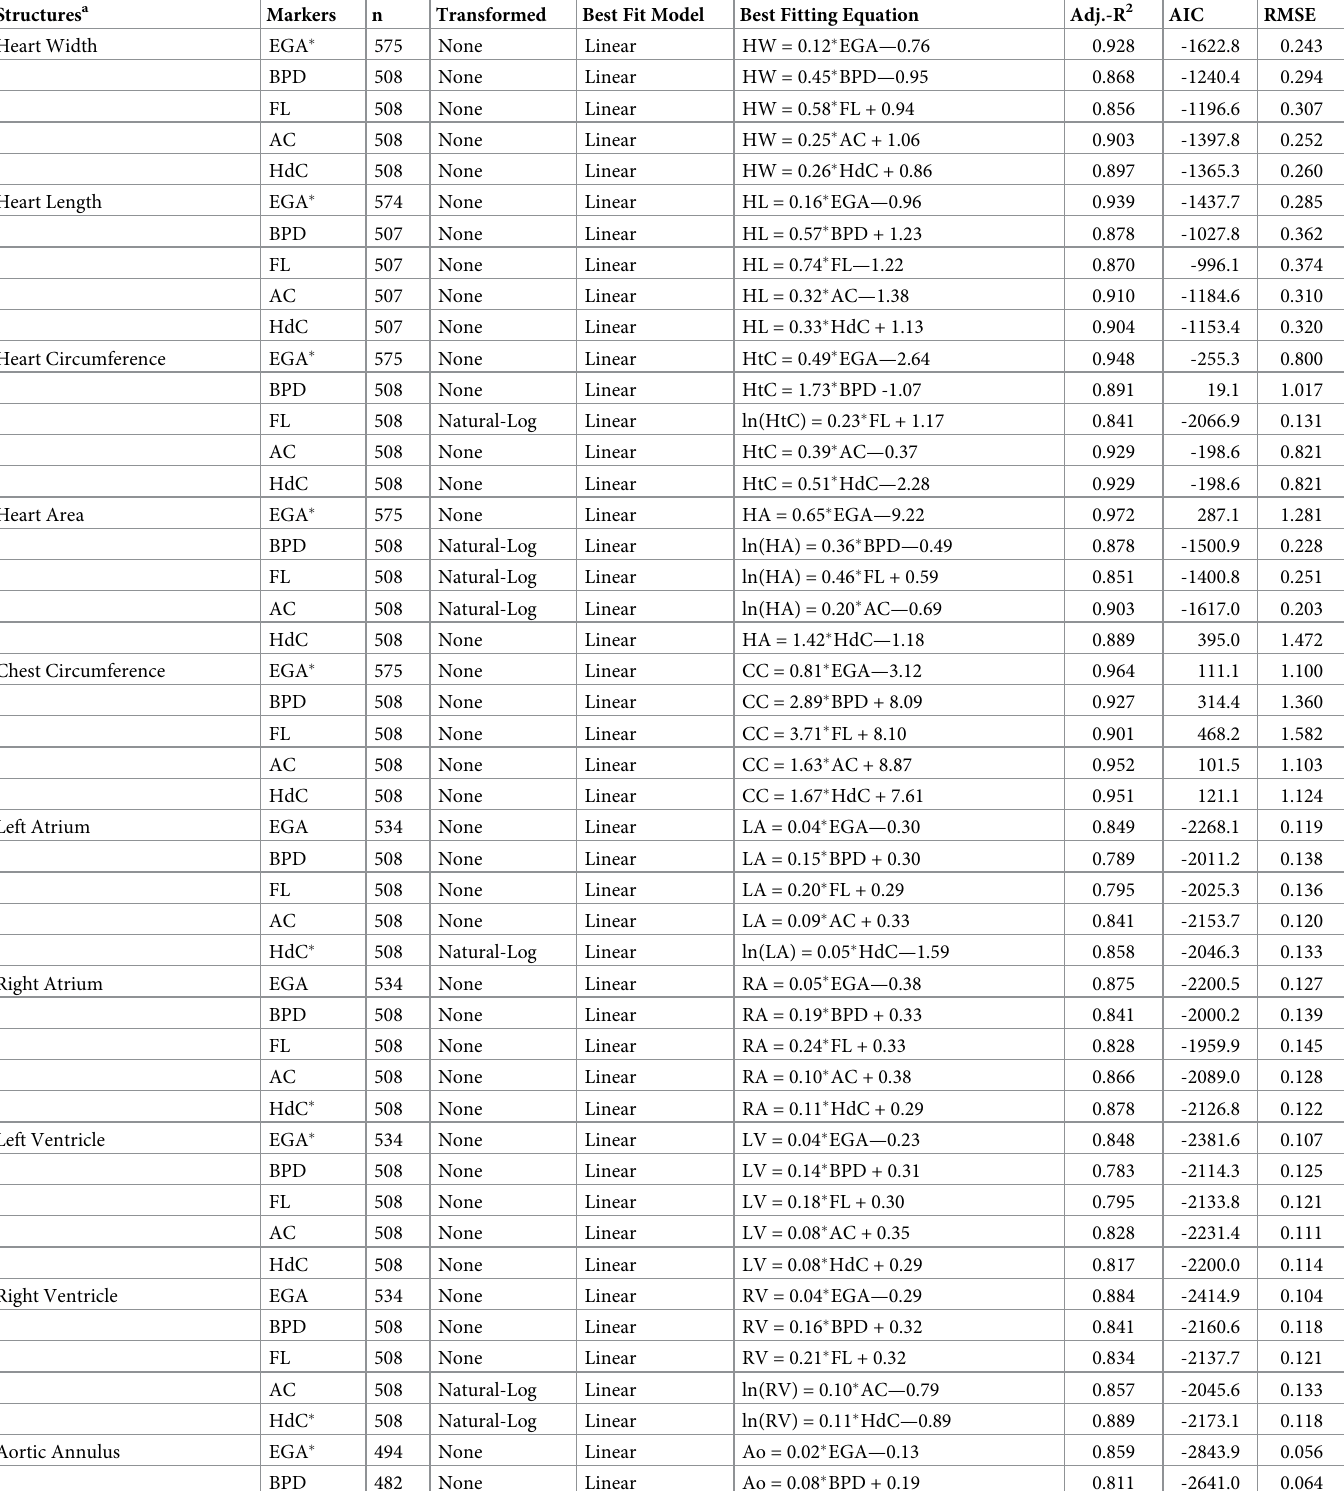
Table 1. Best fitting models for each fetal heart structures. Structures